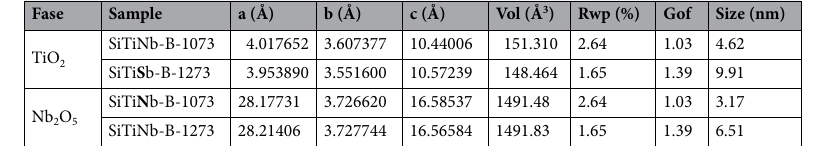
Table 2. Crystallographic data of the SiTiNb-B samples thermally treated at 1073 and 1273 K.